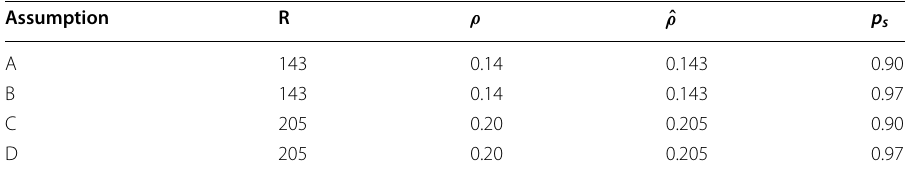
Table 4 Variable values used for each assumption scenario